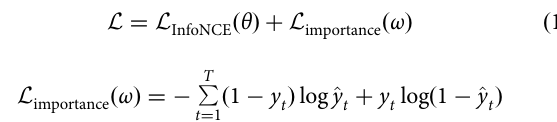
frames. We refer to this method as TWIX throughout the paper.